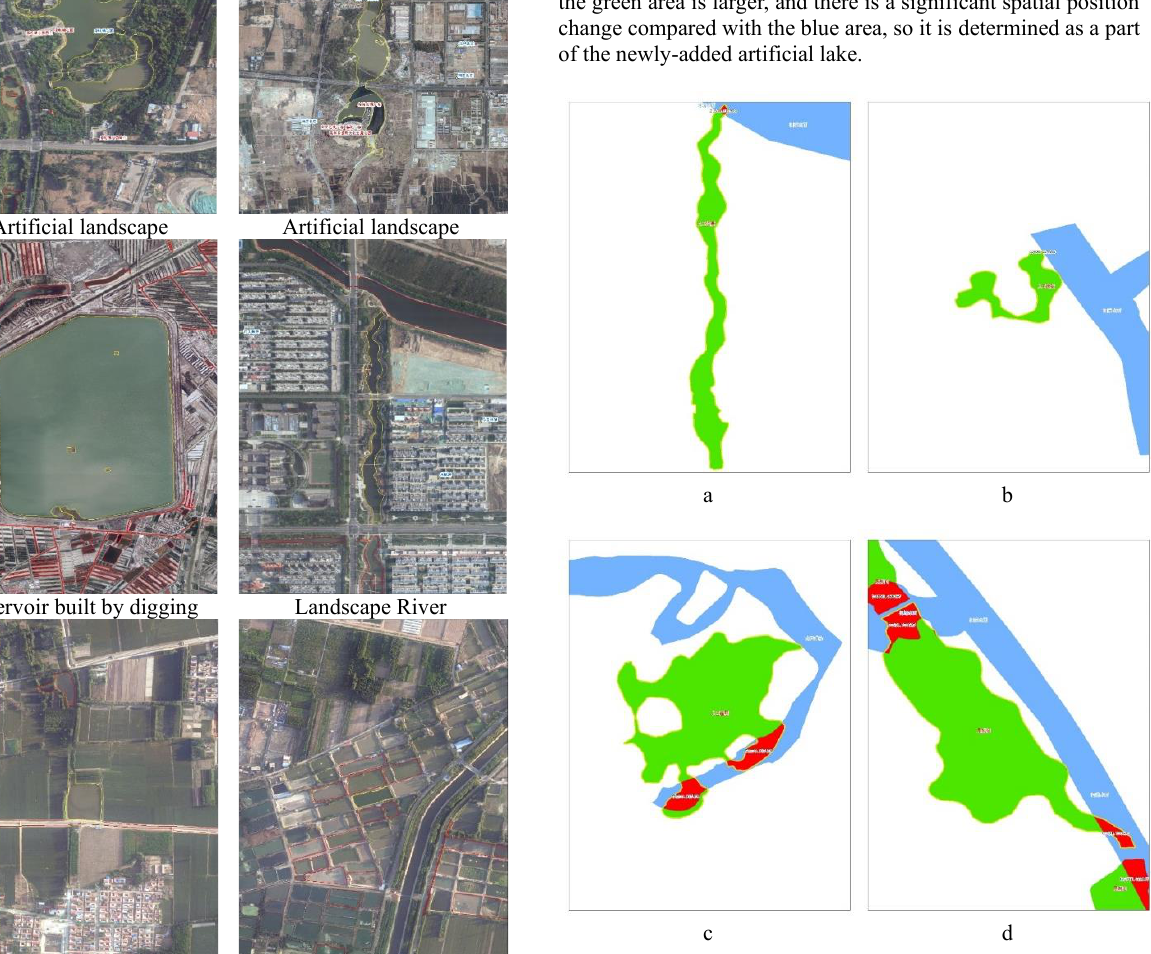
Figure 3 . Schematic diagram of artificial lake change